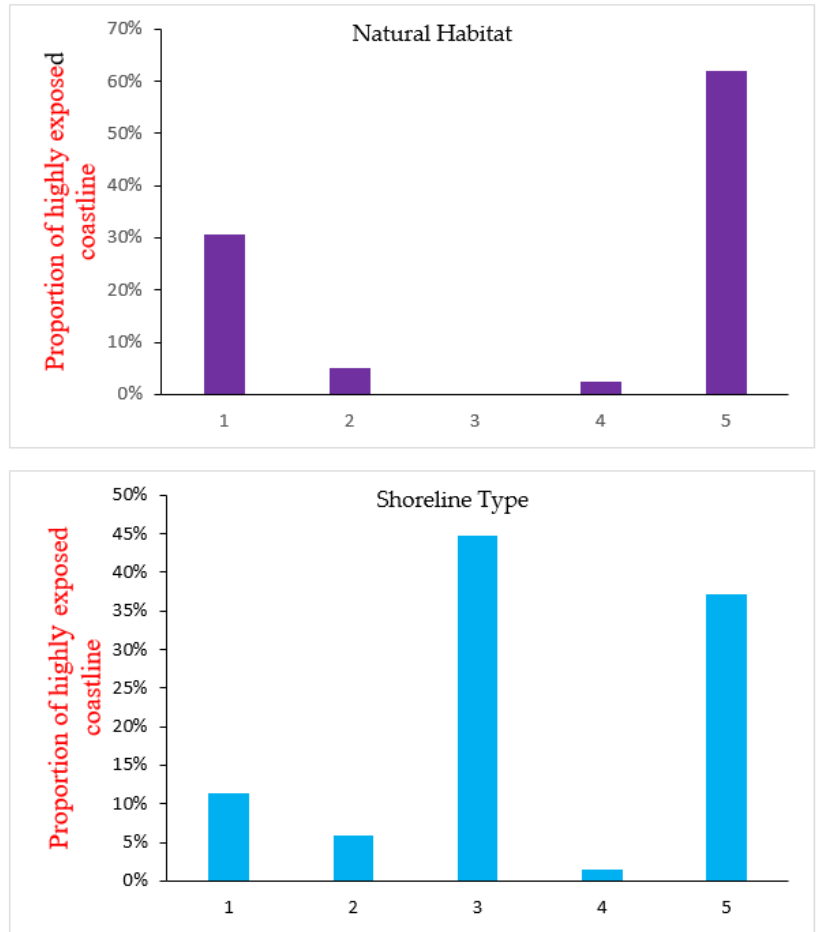
Figure 3. Distribution of ranks for individual variables in the coastal hazard index for each 250-m coastal segment of the study area. A rank of “1” contributes to the lowest exposure, while a rank of “5” contributes to the highest exposure.